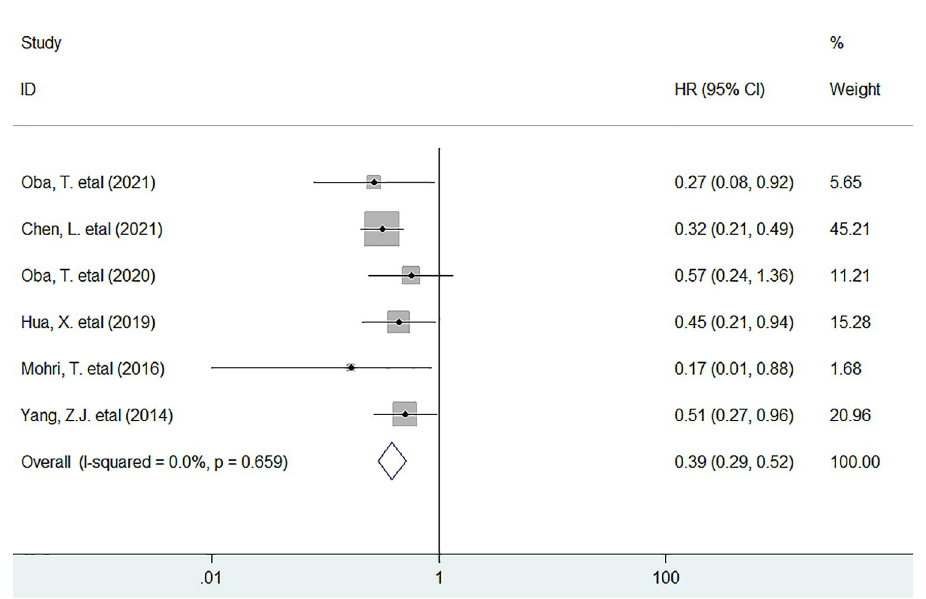
Fig 2. Forest plots describing HR of the association between low baseline PNI and OS in breast cancer patients. HR: hazard ratio; PNI, prognostic nutritional index; OS: overall survival.